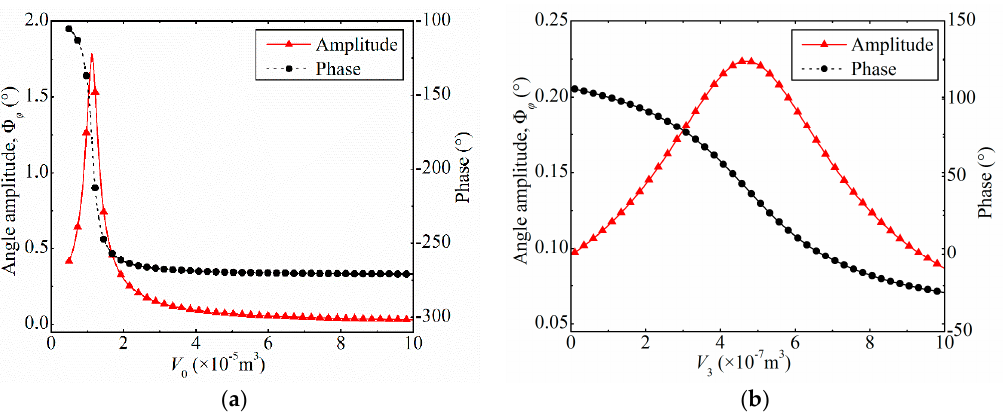
Figure 7. The influence of the volume of the chambers. ( a ) The outlet chamber ( V 0 ) and ( b ) the actuator piston chamber ( V 3 ).